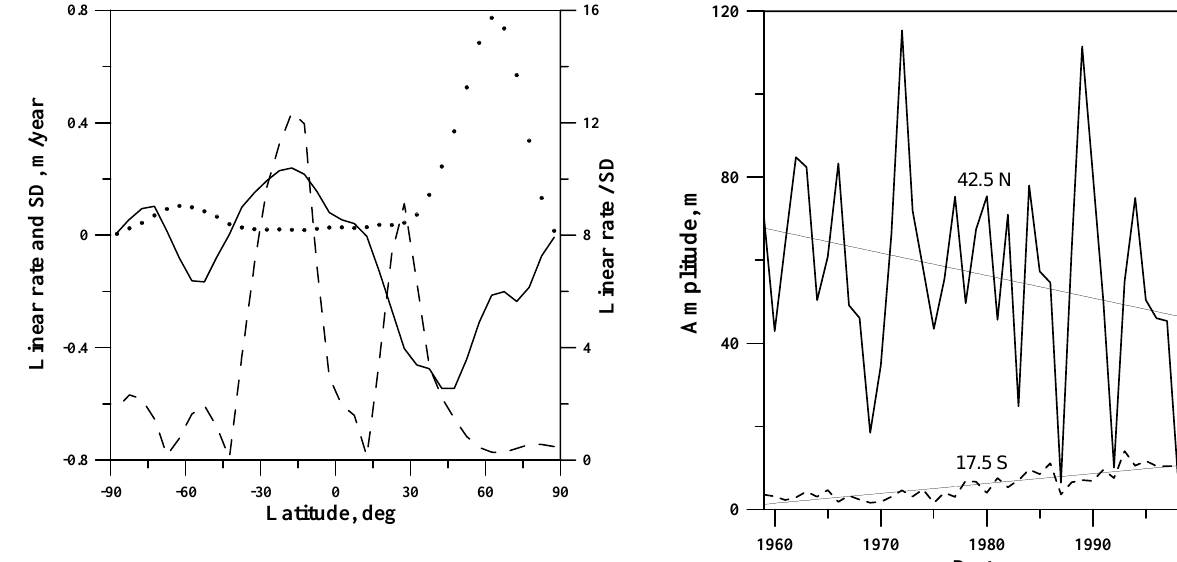
Fig. 11. The same as in Fig. 10, but for the SPW2.